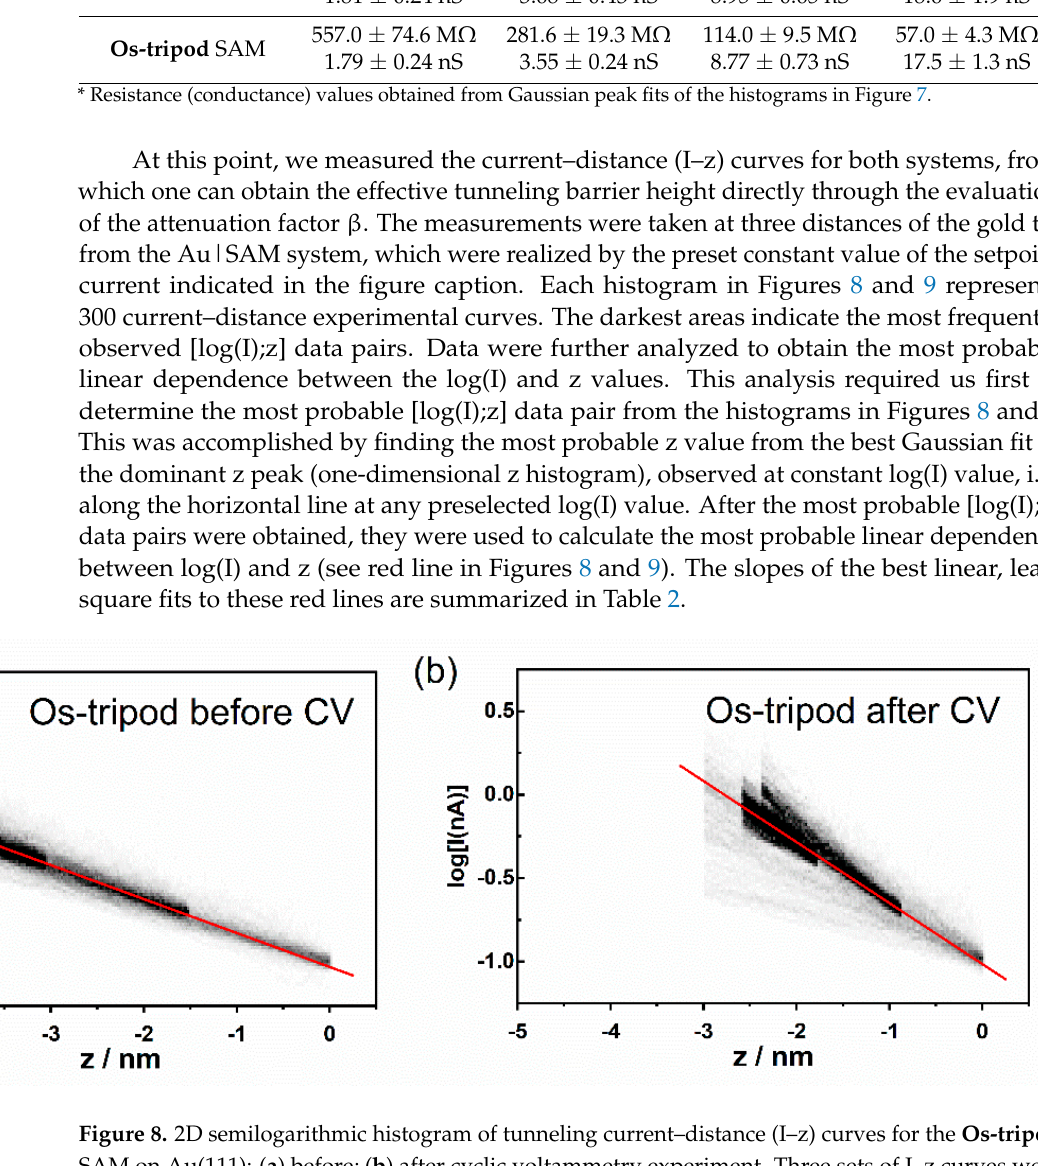
Figure 9. 2D semilogarithmic histogram of tunneling current–distance (I–z) curves for the Ru-tripod SAM on Au(111): ( a ) before; ( b ) after cyclic voltammetry experiment. Three sets of I–z curves were measured starting at setpoint currents of 0.1 nA, 0.2 nA and 0.4 nA. Approach rate was 1 nm s − 1 , bin size log(I) = 0.02, z = 0.02 nm. Red line represents the best least square fit of the most probable log(I) values as a function of z. Figure 8 shows the 2D semilogarithmic histogram of the I–z curves for the Os-tripod SAM before and after electrochemical experiment. Figure 9 shows the same for the Ru- tripod SAM. Although there is a slope change in the log(I)-z histogram for osmium-based films before and after the electrochemical experiment, no such change was observed for Ru-tripod SAMs. This result is in accordance with the AFM observation of the structural change of the SAM in the case of the Os-tripod film. The actual values of the attenuation factors β are summarized in Table 2. They represent the slopes of the red lines in Figures 8 and 9. The β attenuation factor of the Ru-tripod SAM changes only slightly from 0.693 nm − 1 to 0.668 nm − 1 ; however, there is a significant change in the β value for the Os-tripod film upon cyclic voltammetric experiment. The β value, corresponding to the Os-tripod SAM structure shown in Figure 4b, is 0.843 ± 0.021 nm − 1 , which is much higher than 0.668 ± 0.007 nm − 1 obtained for the Ru-tripod SAM (see corresponding SAM structure in Figure 5b). This experimental result means that the effective barrier height for charge transport should be much smaller for the Ru-tripod SAM compared with the Os-tripod SAM struc- ture.